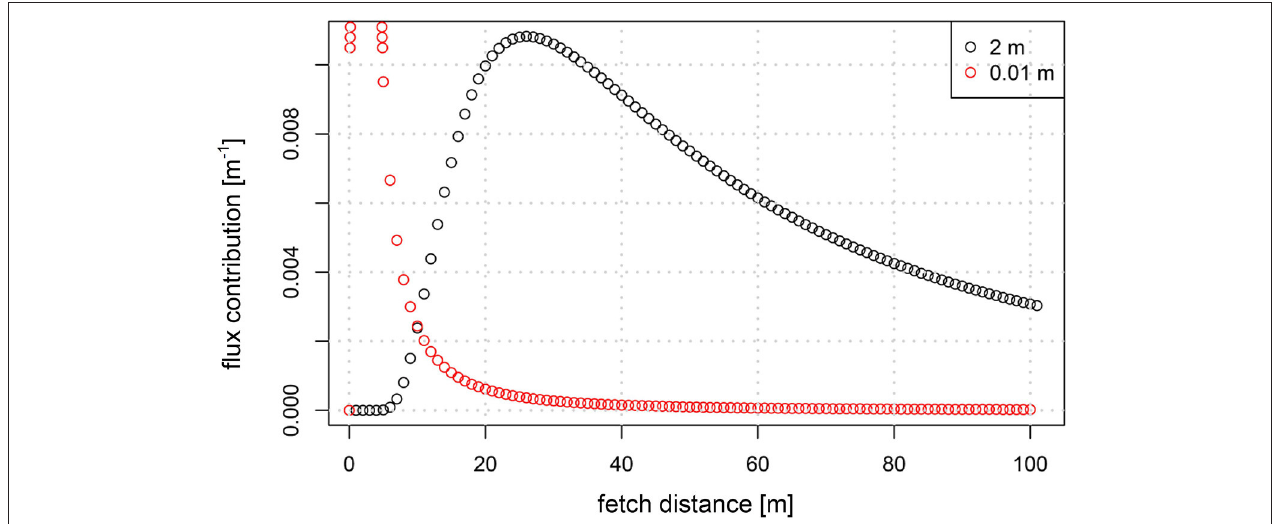
FIGURE 2 | Flux contribution ( FC ) [m − 1 ] as a function of the fetch distance for a measurement height of 2m (black) and a theoretical measurement height of 0.01m (red). In this example the wind velocity is 1m s − 1 and the friction velocity is 0.1m s − 1 .